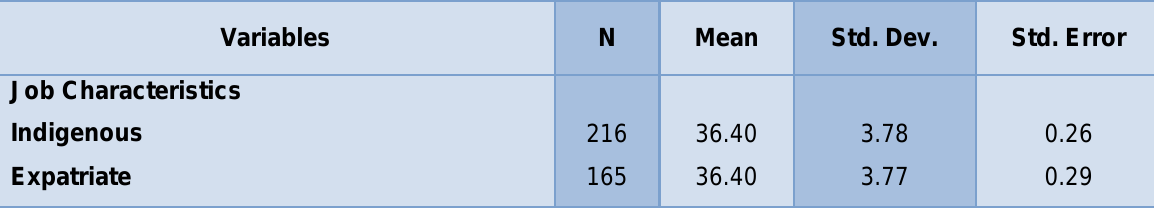
Table 6 Descriptives of independent samples t-test of job characteristics of construction professionals in indigenous and expatriate construction companies Std. Dev. = Standard